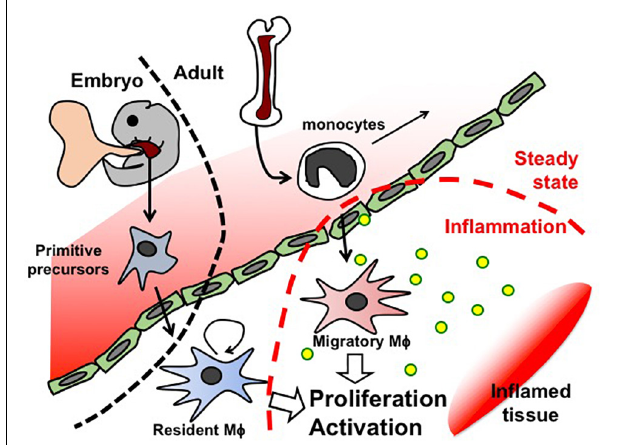
FIGURE 1 | Schematic representation of versatile functions of M φ during AKI.